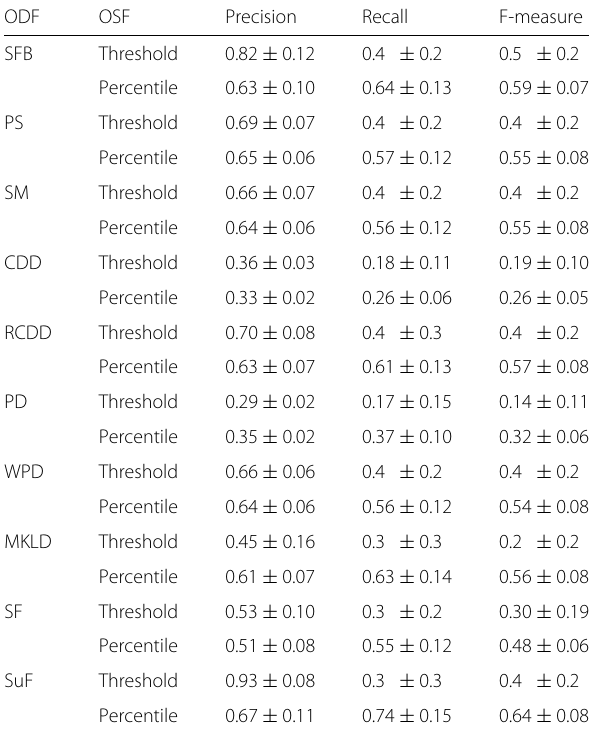
F-measure for the static evaluation of the different detection (ODF) and selection (OSF) methods considered ODF